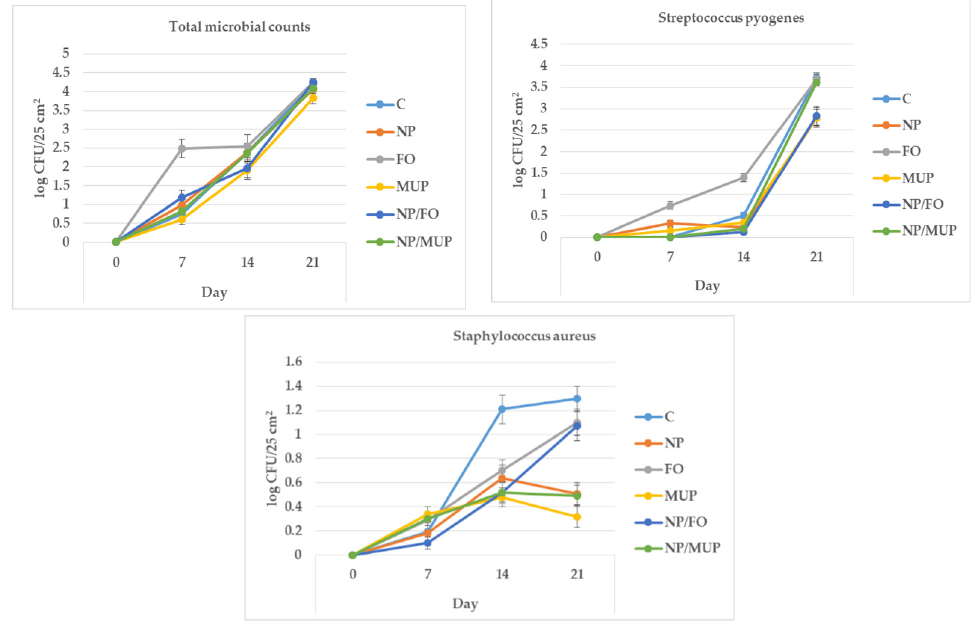
Figure 6. Change in microbial counts over time after excision for wounds treated with dressing alone (control, C); dressing with empty poly(lactic-co-glycolic) acid (PLGA)-polyvinyl alcohol (PVA) nanoparticles (NPs) (NP); dressing with fish oil (FO); dressing with mupirocin (MUP); dressing with PLGA-PVA NPs with entrapped fish oil (NP/FO) and dressing with PLGA-PVA NPs with en- trapped mupirocin (NP/MUP) . mupirocin